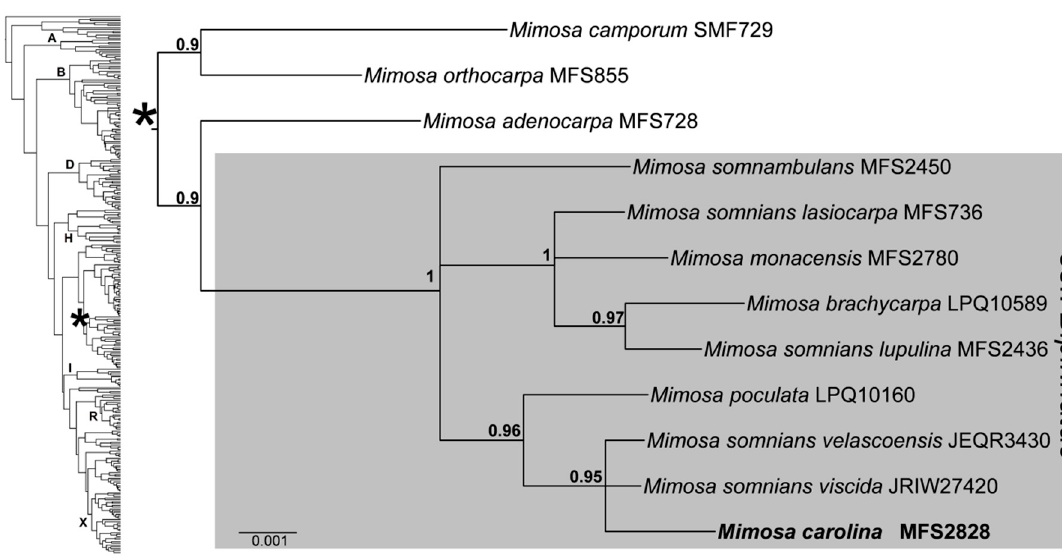
Figure 4. Phylogeny of members of ser. Bipinnatae including the new species Mimosa carolina based on a Bayesian analysis of the plastid trnD ‐ trnT locus. Numbers above nodes of the majority rule consensus tree are posterior probability values (PP). On the left, a scheme of the phylogeny of the genus Mimosa from Simon et al. (2011) showing the main clades (letters) and approximate position (asterisk) of the clade shown in the right panel. Table 1. Key to Identify Mimosa carolina and Similar Species from Mimosa sect. Habbasia ser. Bipinnatae (Steps 2, 11 and 12 are adapted from Barneby [4]).